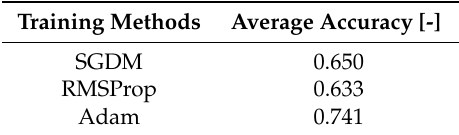
Figure 11. BUVs participating in real test of OCUV in the Baltic Sea. Table 3. The results of DLNNs trained using SGDM, RMSProp and Adam methods in the real test in the Baltic